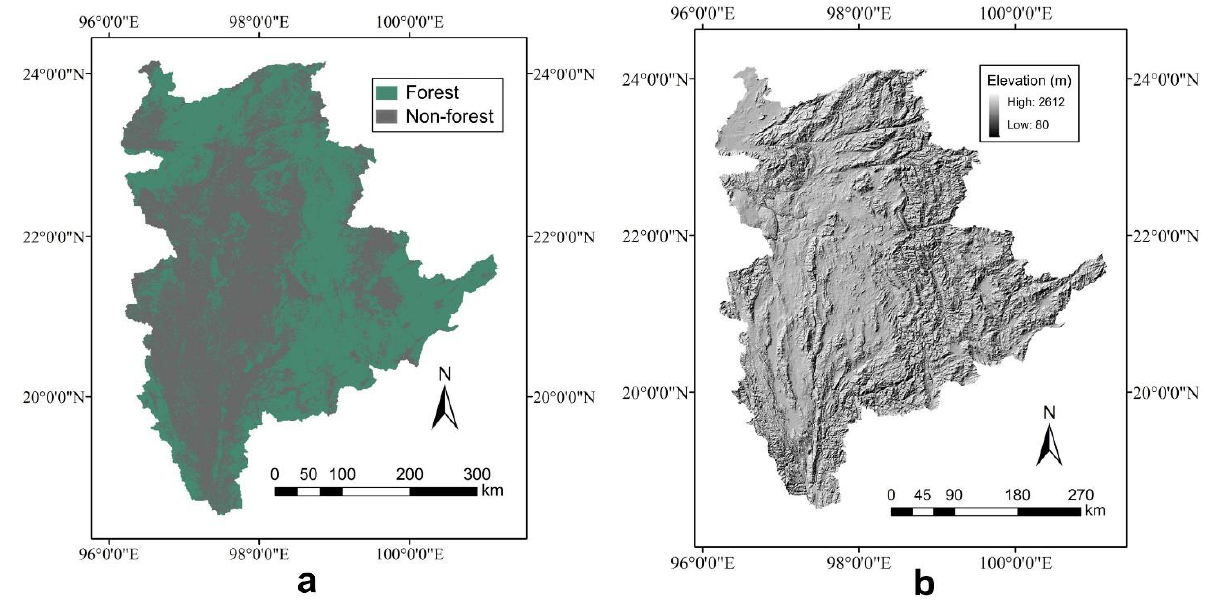
Figure 1. Forest distribution and elevation in upland Myanmar: ( a ) forest and non-forest areas in upland Myanmar; and ( b ) elevation map of upland Myanmar.